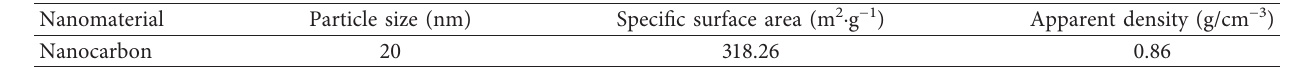
Table 2: Properties of carbon nanoparticles.